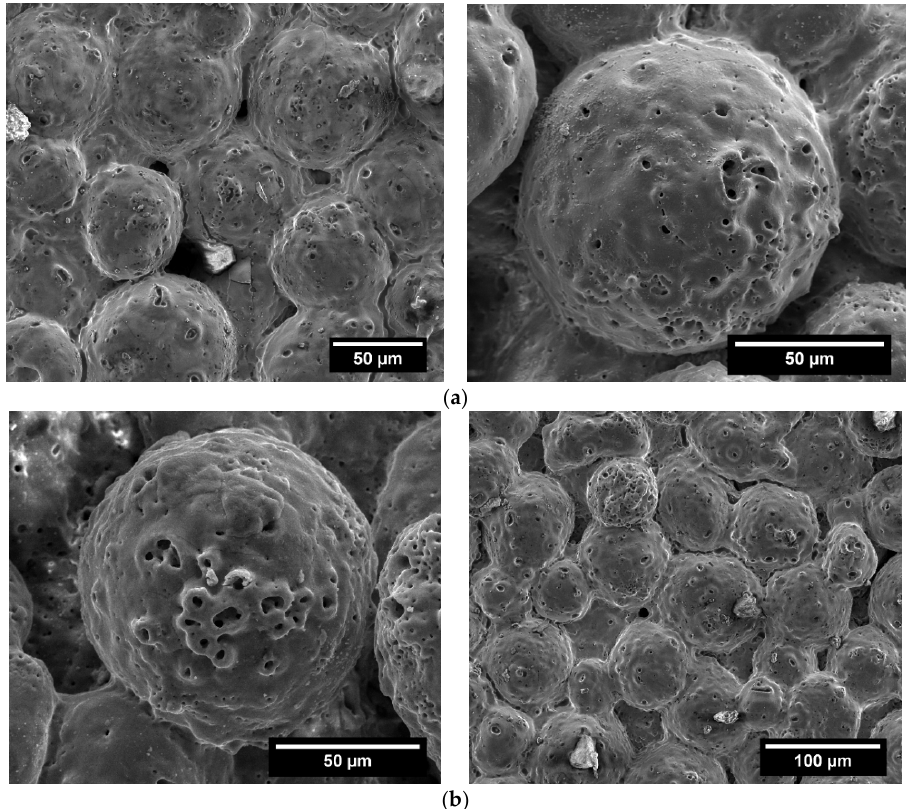
Figure 12. Morphology of the coating developed by PEO treatment for: ( a ) 4 min; ( b ) 8 min.